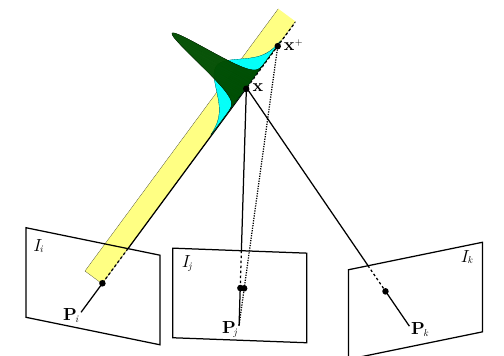
Figure 2. The measurement uncertainty of a depth point from two images can be computed through x and x + as in the REMODE approach (Pizzoli et al., 2014) for 3D reconstruction from monocular images.